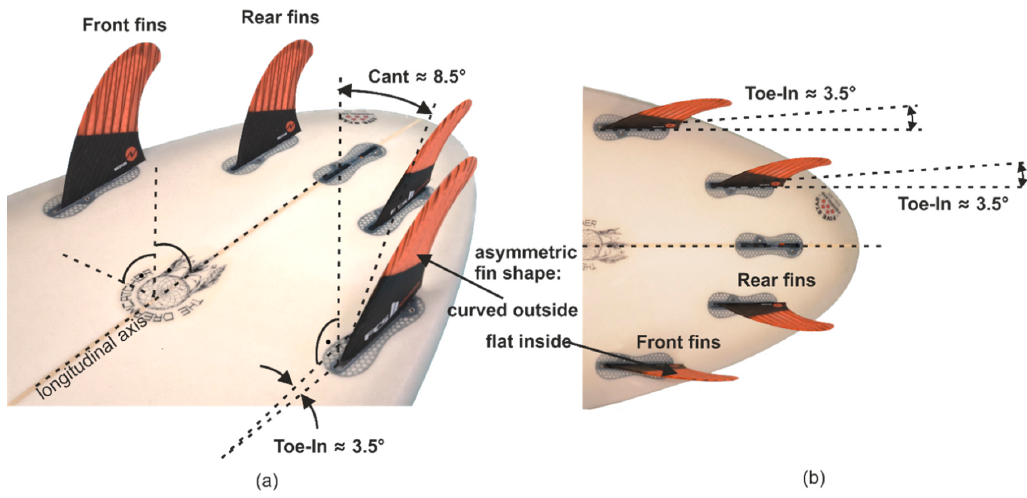
Figure 5. ( a ) Cant and Toe-In angle of the surfboard fins. ( b ) The asymmetric and symmetric shapes of the rail fins and the center fin are visible in the bottom view of the surfboard.